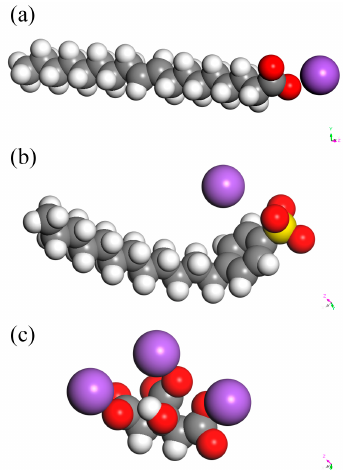
Figure 6. Structure of ( a ) sodium oleate, ( b ) SDBS, and ( c ) sodium citrate. (Note: Red balls represent O. White balls represent H. Yellow balls represent S. Green balls represent Ca. Purple balls represent Na).